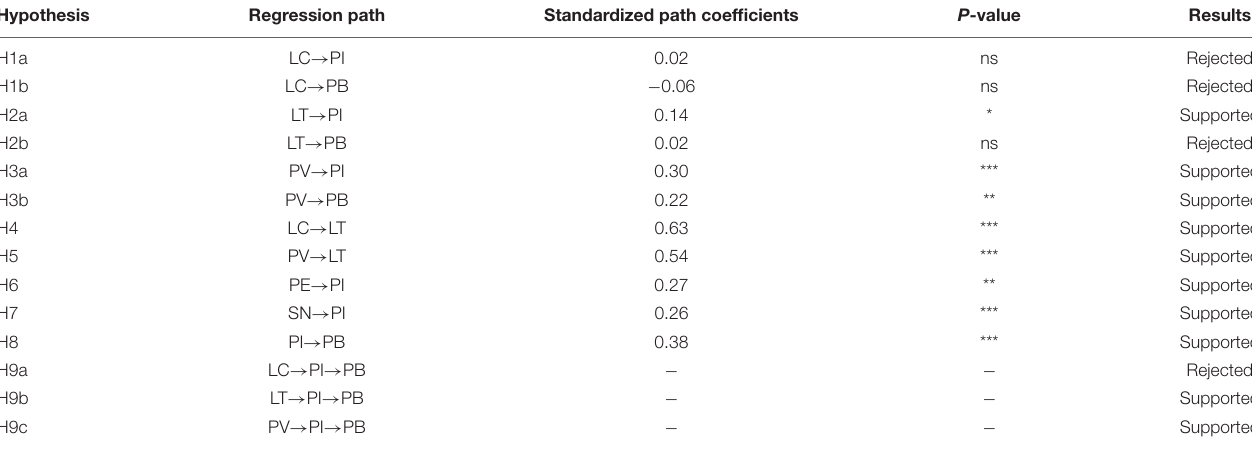
TABLE 5 | Hypothesis test results.